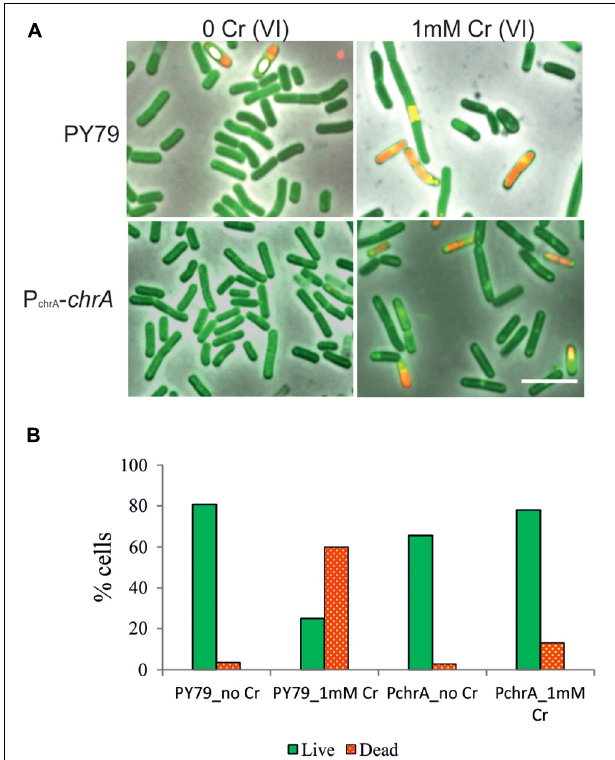
FIGURE 5 | Live/Dead staining of B. subtili s PY79 and P chrA -ChrA strain. (A) Fluorescence microscopy images of Live/Dead staining of PY79 and P chrA -ChrA strains exposed to 1 mM Cr(VI) for 6 h, together with respective controls grown without Cr. After exposure to Cr(VI) cells of both strains tend to be longer, with multiple shape irregularities. The panels are overlay of phase contrast and fluorescence images. The scale bars represent 5 µ m. (B) Statistics of the Live/Dead staining experiment. The number of live cells (green, stained by Rhodamin 123) and the number of dead cells (red, stained by PI) were expressed as a percentage of all cells in recorded images. At least 750 cells were analyzed for each sample.